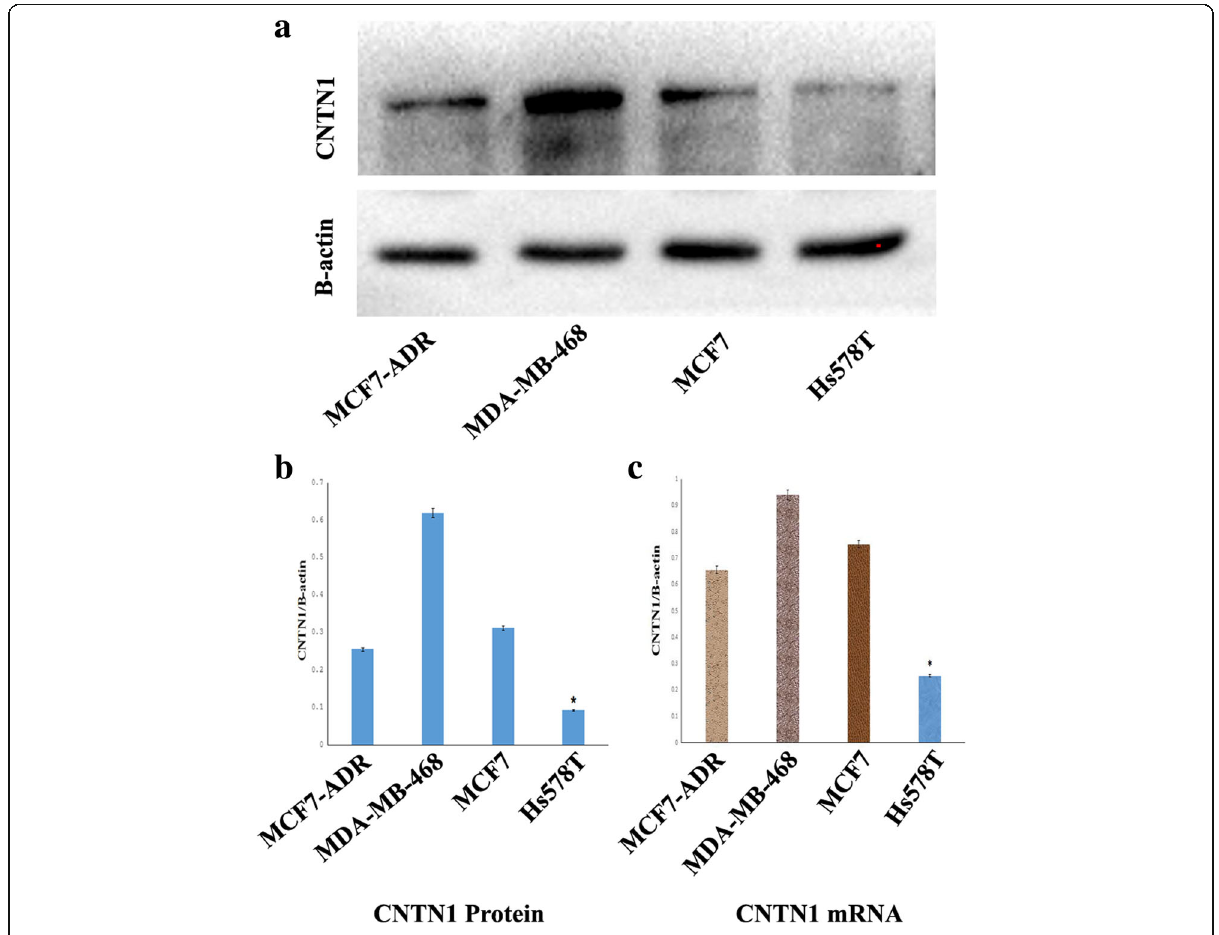
Fig. 1 Expression of CNTN1 in breast cancer cell lines. a Expression of CNTN1 in MCF7-ADR, MDA-MB-468, MCF7 and Hs578T cells was assayed by western blot. CNTN1 was the least expression compared with controls ( * P <0.05) ( b ). Western blot. Bands were quantified by densitometry and CNTN1 was normalized to B-actin levels. c Real-time RT-PCR. Expression of CNTN1 mRNA was the least expression compared with controls ( * P